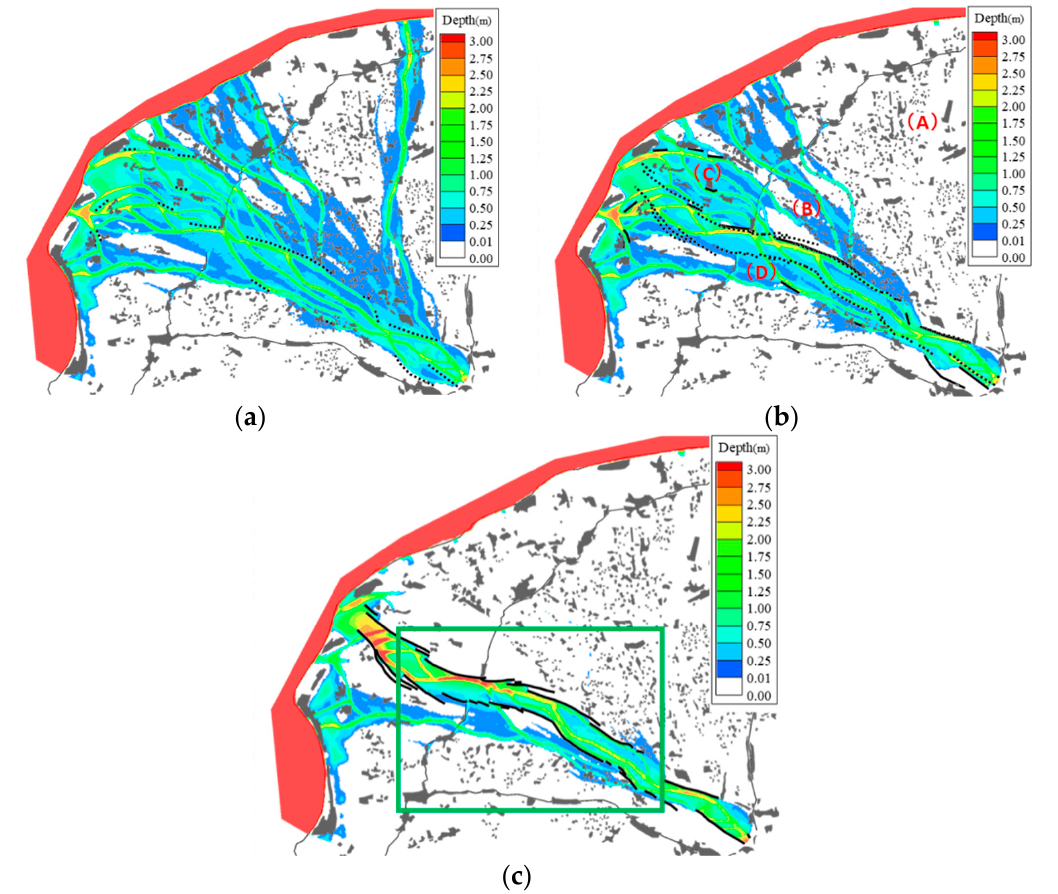
Figure 12. ( a ) Inundation depth distribution Case (a): elapsed time = 41 h. ( b ) Inundation depth distribution Case (b): elapsed time = 41 h. ( c ). Inundation depth distribution Case (c): elapsed time = 41 h.